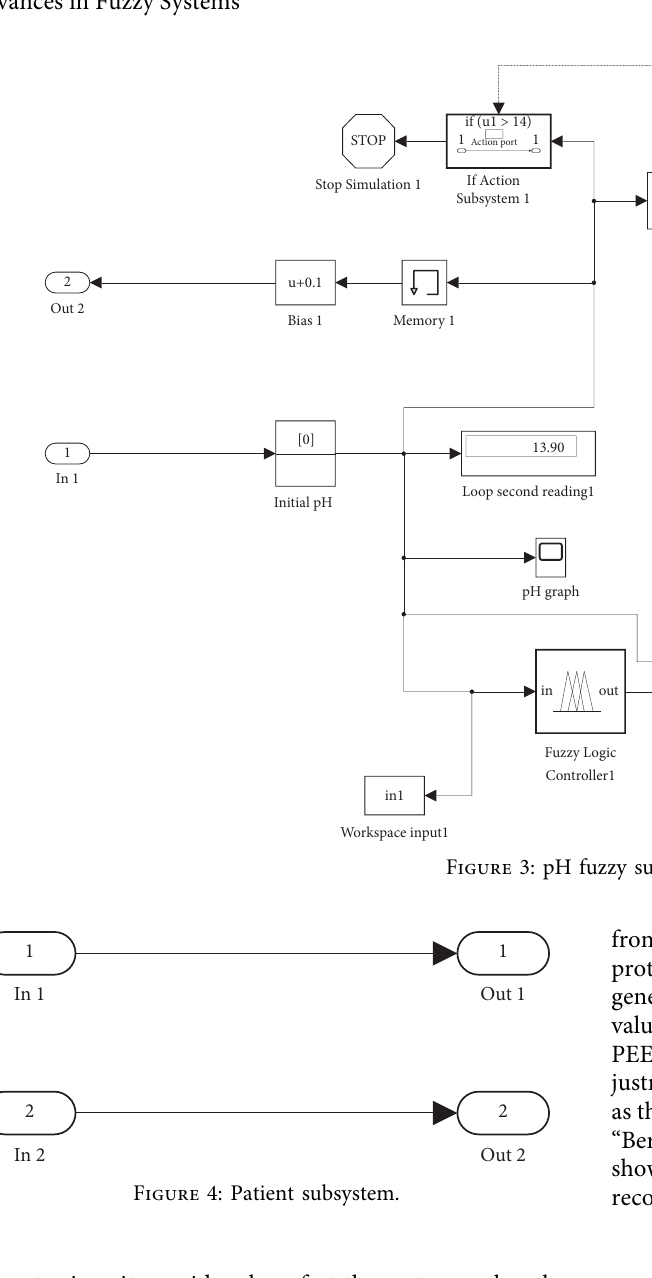
PEEP Output Graph. Figure 15 shows the simulated results after employing the fuzzy logic reasoning of the high PEEP algorithm. As explained previously, the plots in yellow colour are the FiO inputs, initial PEEP inputs are in blue 2 colour, and the fuzzifed outputs (labelled as “adjusted PEEP output” on the graph) are in the red colour. Te graph shows how the FiO input when adjusted afects the fuzzifed 2 outputs. For example, when the FiO value changed from 2 0 (zero) to 0.1, no change was indicated in the fuzzifed output since the recommended PEEP is not indicated in Table 1. When the FiO input changed to 0.3, the fuzzifed 2 output changed on the graph to match the recommended PEEP value of up-to 14 as shown in Table 1. Te graph shows that it covers up the data missing in Table 1; when FiO input 2